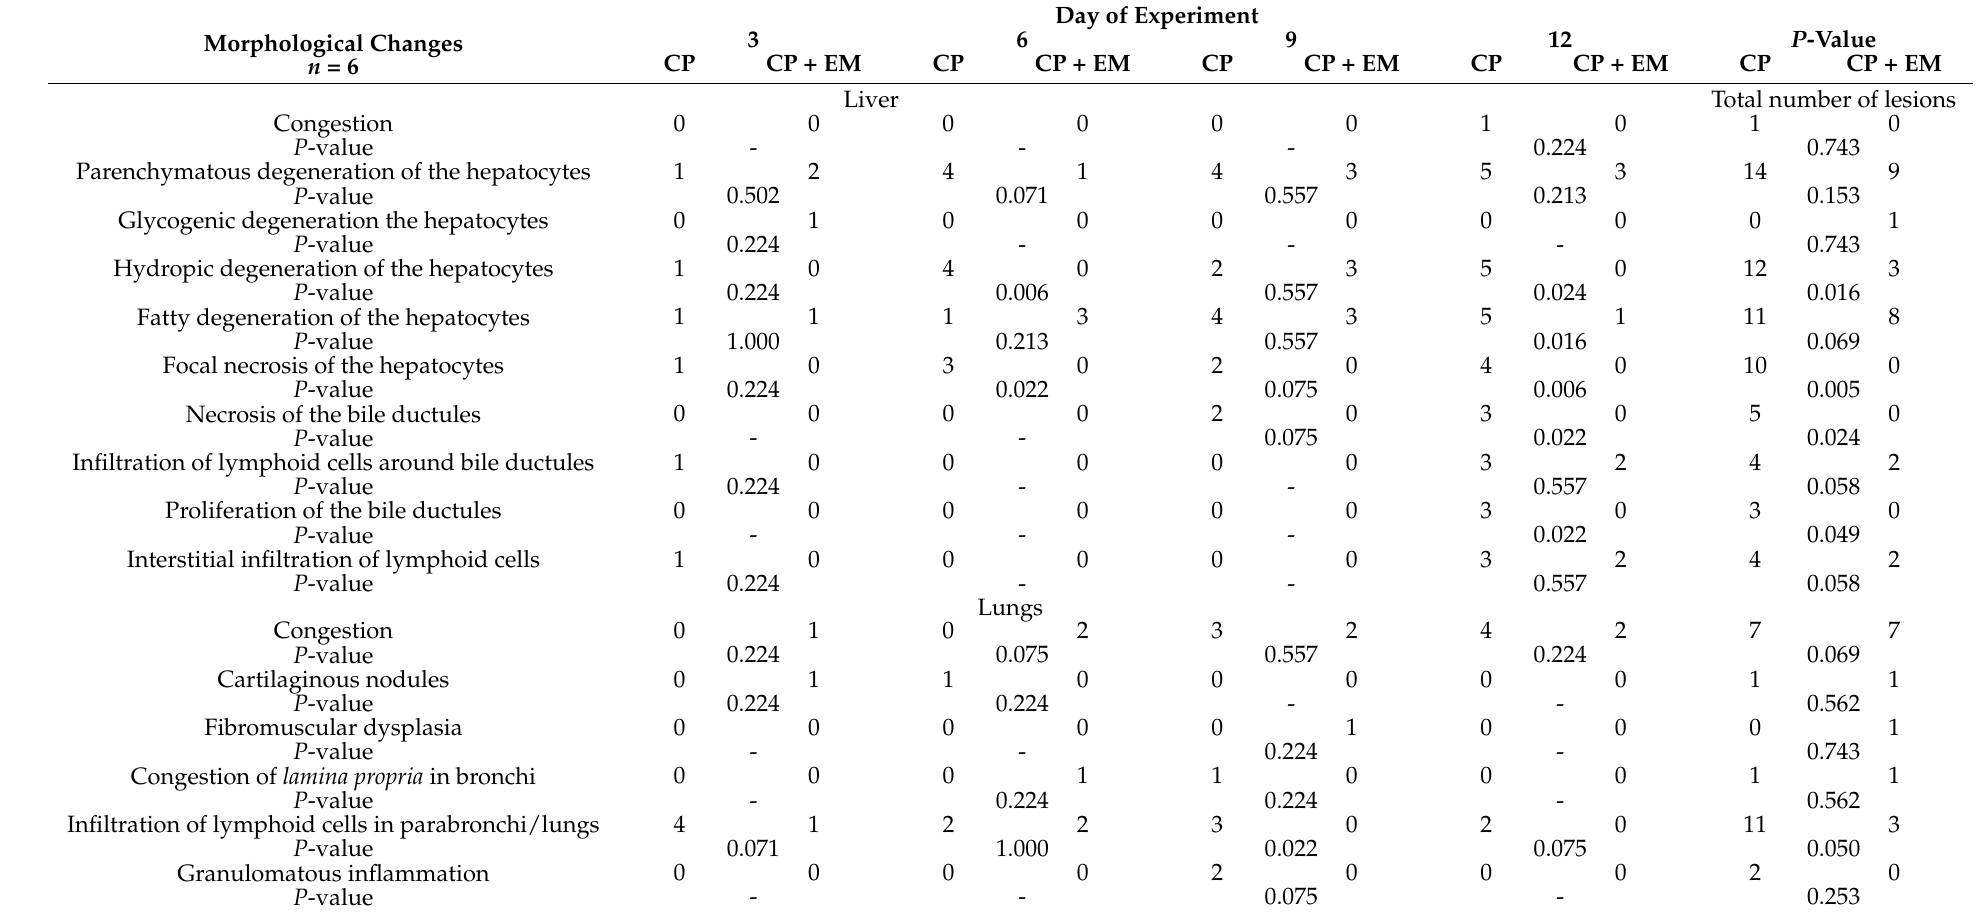
Table 2. Effect of EM supplementation on morphological lesions in the liver and lungs in quails challenged with C. perfringens